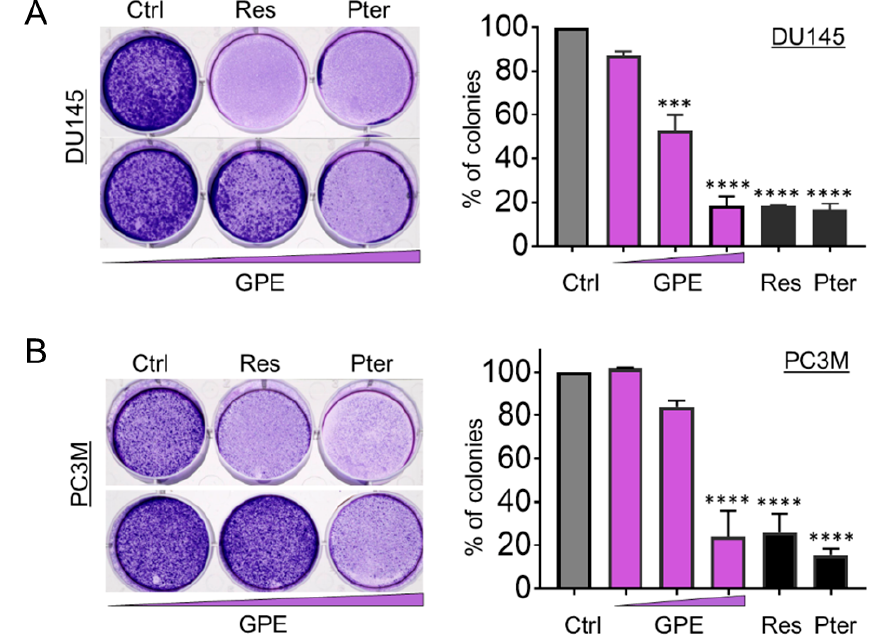
Figure 2. GPE reduces colony formation in DU145 and PC3M prostate cancer cells. Representative images of colony formation ability of ( A ) DU145 and ( B ) PC3M cells after treatment with GPE (1.5; 15; 100 µ g/mL) and Res and Pter (1.5 µ g/mL). Data represent the mean ± SEM of three independent experiments with duplicate wells. *** p < 0.001 and **** p < 0.0001 (one-way ANOVA) were assessed as significant differences between treated and Ctrl vehicle cells.